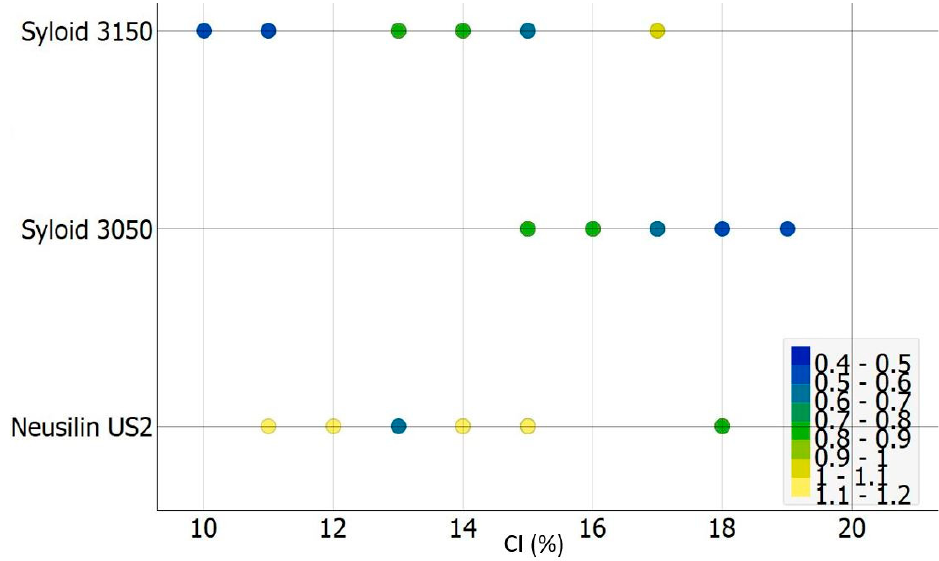
Figure 4. Carr index values depending on the carrier used. The color of the circles corresponds to liquid load factor (the colours follow the values given in the legend).